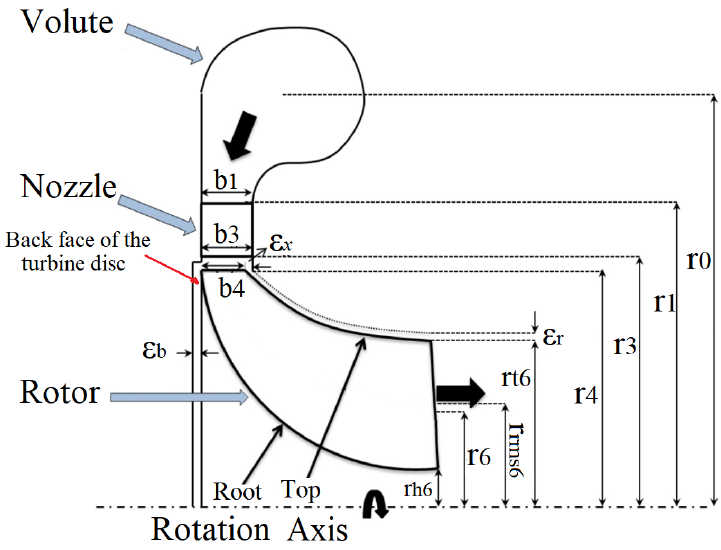
Figure 6. Schematic representation of the radial turbine and the main geometric design parame ‐ ters.